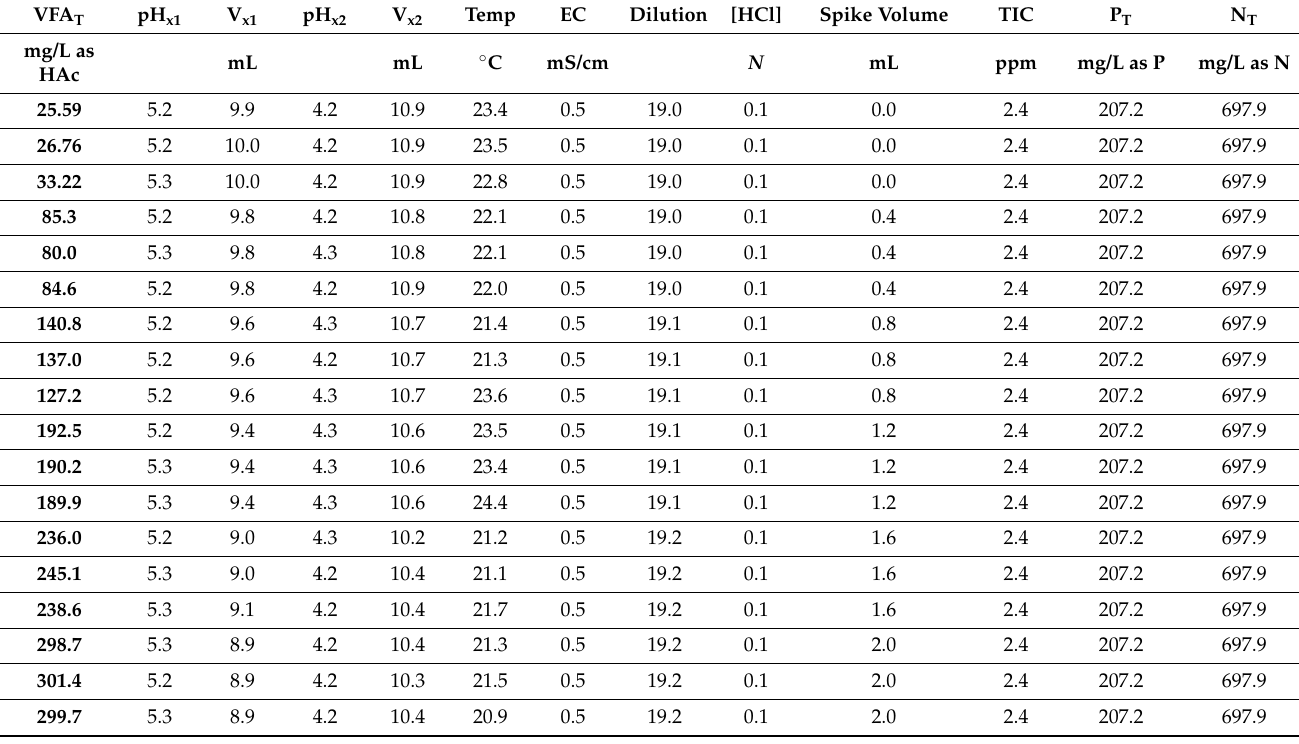
Table A2. Results of Haifa VFA T +